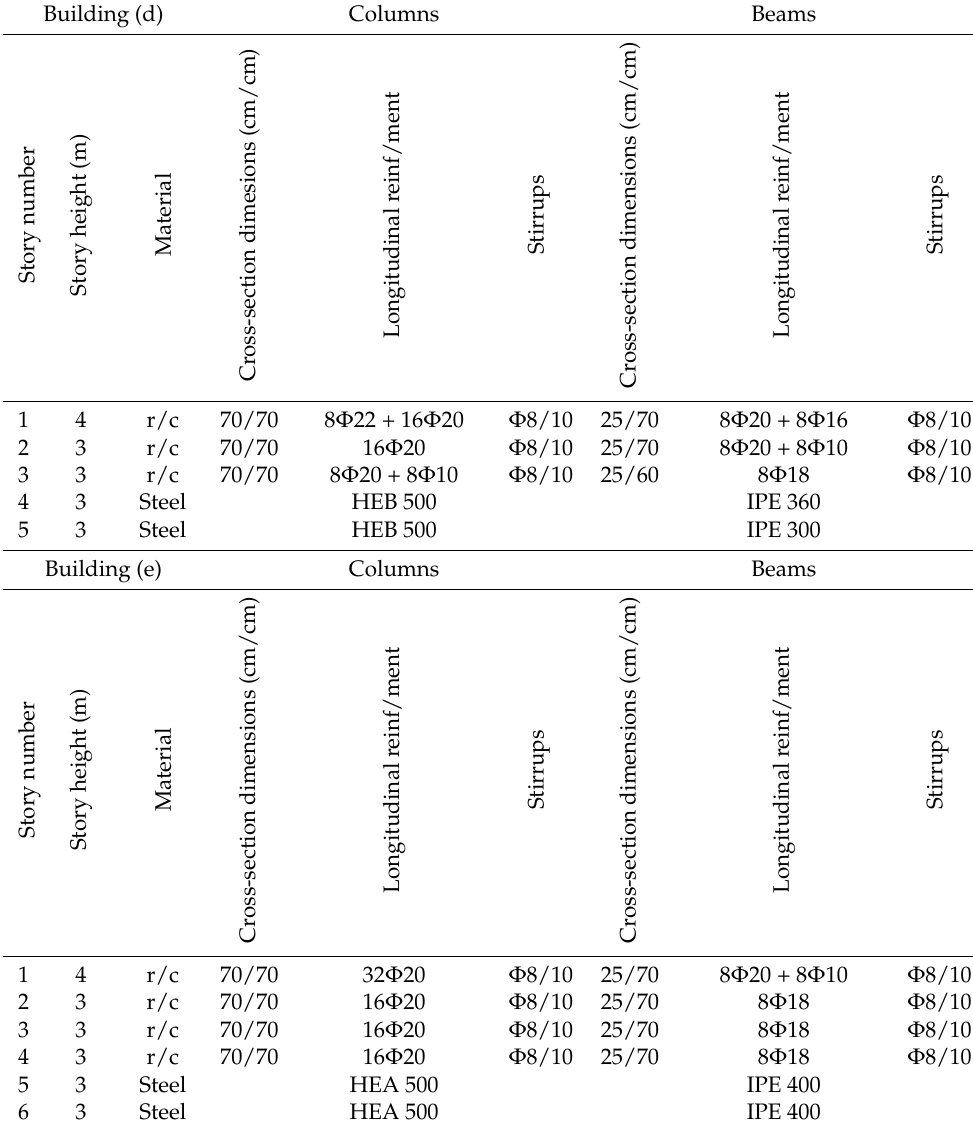
Table 1. Cont . Building (d) Columns